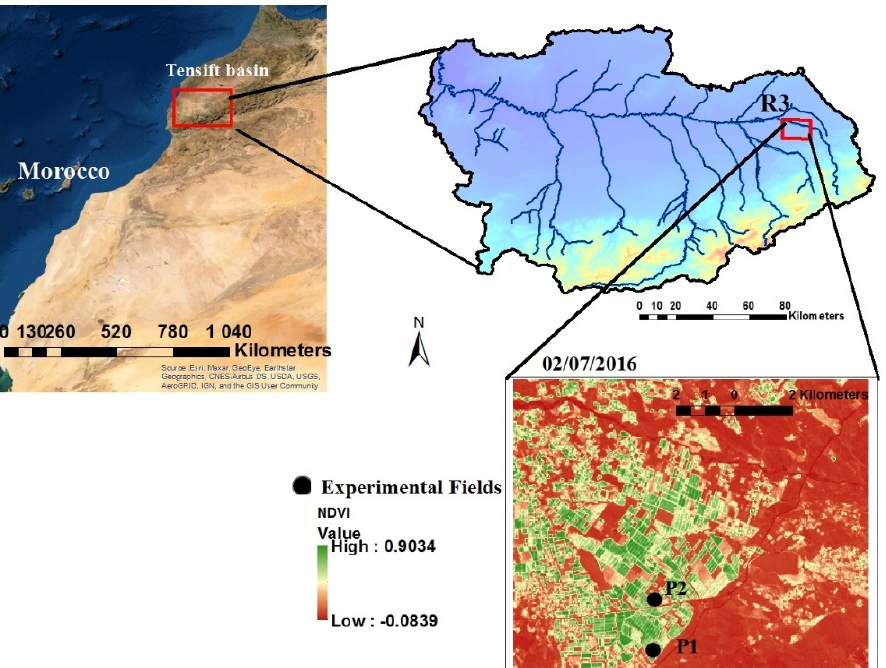
Figure 1. The study sites’ locations and both wheat fields (black dots) equipped with the eddy covariance systems in the Tensift basin in Marrakech, Morocco.